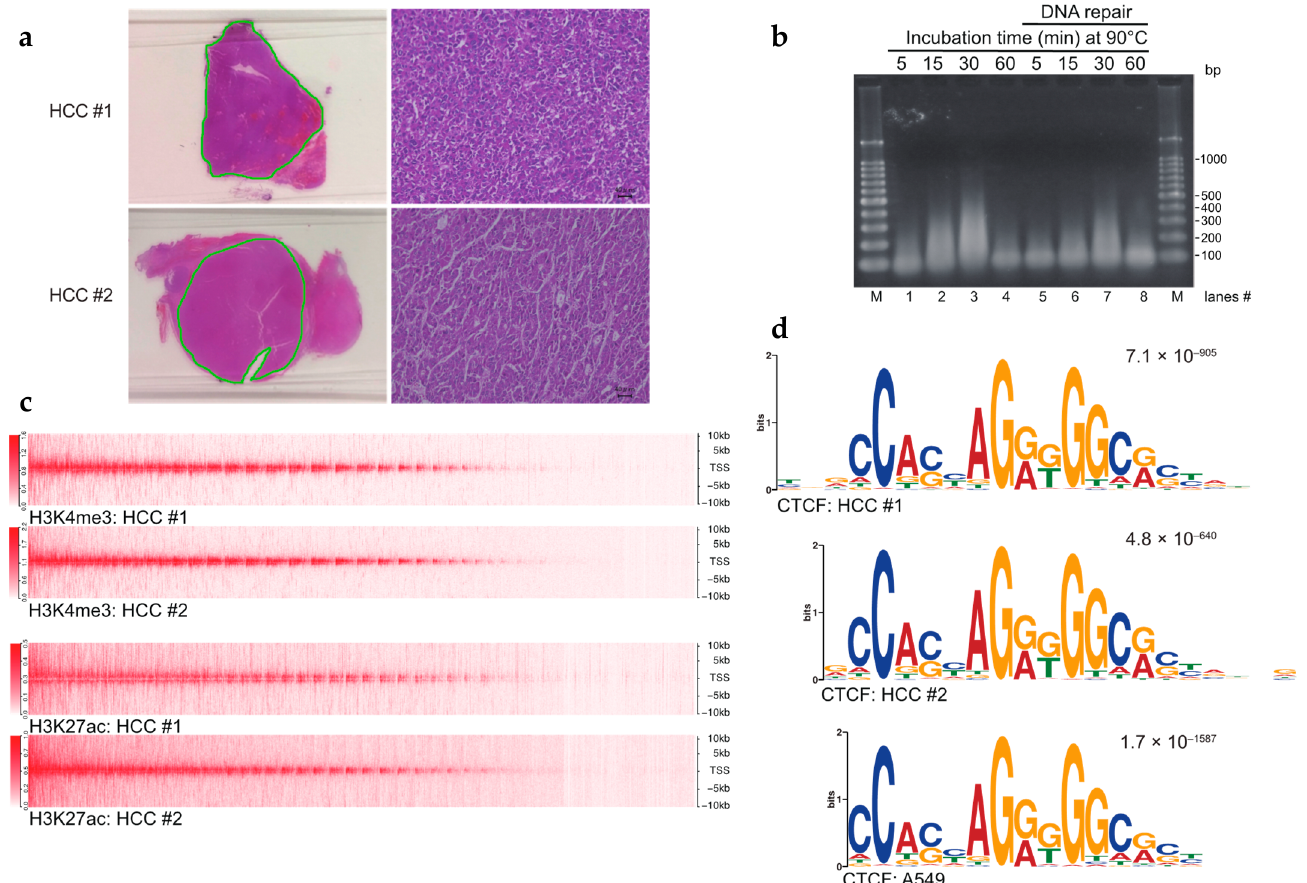
Figure 1. Establishment of the FFPE ChIP-seq procedure. ( a ) Hematoxylin and eosin (H&E) staining of hepatocellular carcinoma (HCC) tissues. Dissected tissues utilized for FFPE ChIP-seq are underlined in green. Higher magnification images (scale bars, 40 µm) are shown on the right sides. ( b ) Controlled heat-treatment of FFPE samples yielded solubilized chromatin. Sectioned FFPE tissues were treated with an overnight incubation at 65 °C followed by indicated time points at 90 °C. Reversed-crosslinked DNAs were repaired in lanes 5–8. Purified DNAs were amplified by whole genome amplification (WGA) and subjected to 1% agarose gel electrophoresis. M: 100-bp DNA ladders. ( c ) Heat map (upper half) showing H3K4me3 enrichment at TSSs ± 10 kb in HCCs. Heat map (lower half) for H3K27ac enrichment. ( d ) Sequence logos of CTCF ChIP-seq in HCCs. The top motif identified by MEME-ChIP, algorithms for de novo motif discovery, is shown. E-values, an estimate of the expected number of motifs with the given log-likelihood ratio, are shown on the upper right. Sequence logos in the A549 cell line were obtained from GSE30263.